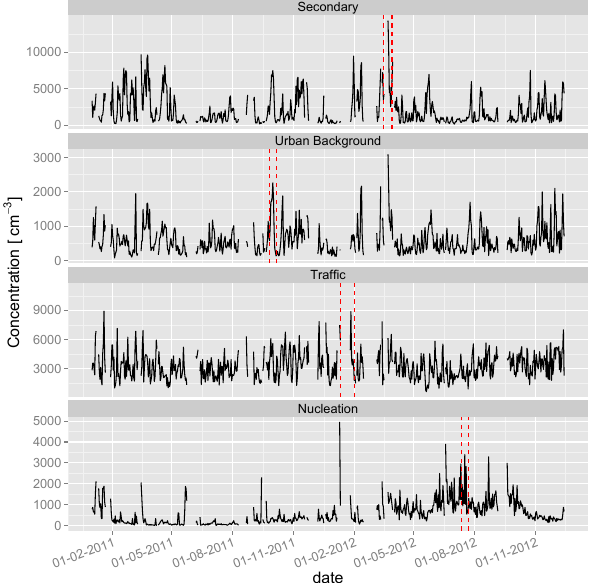
Figure 8. Daily factor scores outputted from PMF2 GF (unit: cm − 3 ) . Vertical red lines indicate when each factor has the high- est daily average contribution to the NSD: 24 March 2012 – sec- ondary; 1 October 2011 – urban background; 27 January 2012 – traffic; 17 July 2012 –